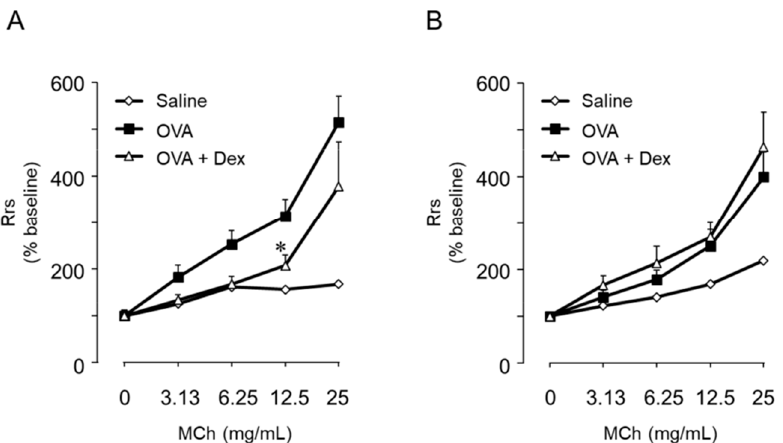
Figure 3. Dexamethsone (Dex) did not attenuate Th9 cell-mediated airway inflammation. Th2 ( A ) or Th9 ( B ) cell-transferred mice were challenged with ovalbumin (OVA) or saline. Mice were treated with either Dex (5 mg/kg) or phosphate buffered saline (PBS) as a control twice, at 1 h before and at 24 h after the OVA challenge, by subcutaneous injection. Seventy-two hours after the challenge, the bronchial responsiveness to inhaled MCh was assessed. Data are expressed as mean ± SEM of 5–7 animals. * p < 0.05, compared with OVA-challenged mice. (Reference [133], modified).